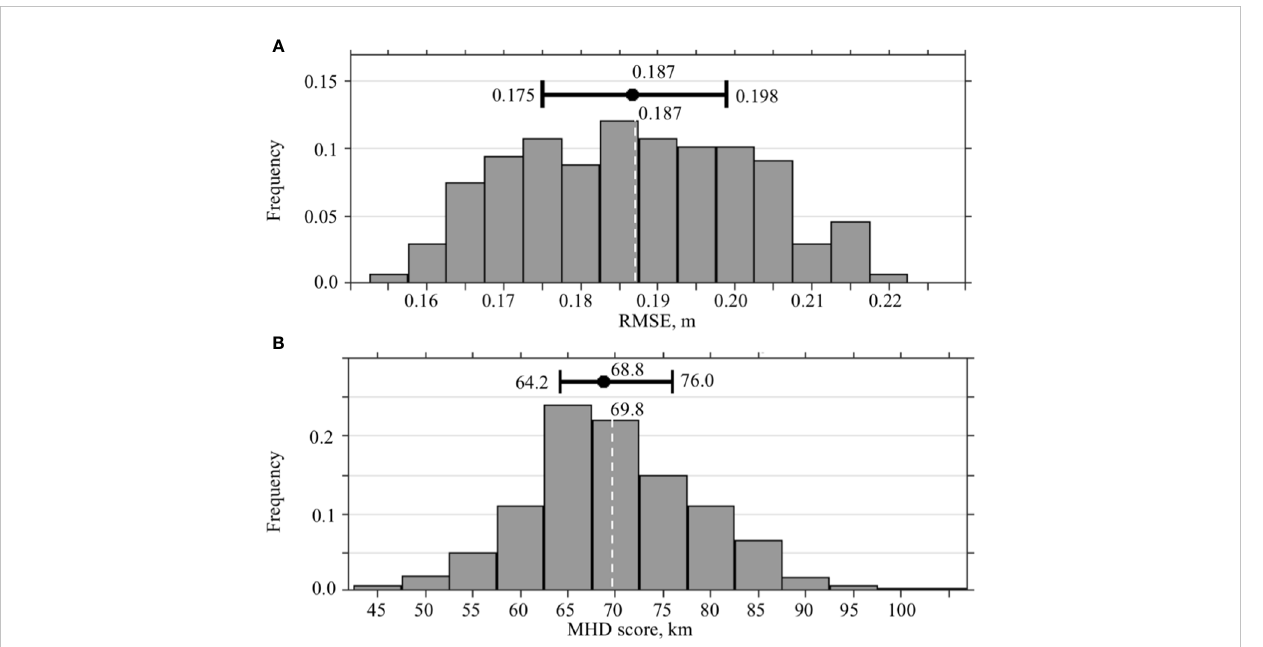
FIGURE 3 Statistics of the RMSE and MHD scores characterizing the saturation value. (A) Distribution of the RMSE between two randomly selected SSH fi elds form the NEMO NR. (B) Distribution of the MHD scores calculated for the LC/LCE fronts derived from randomly selected SSH fi elds from the NEMO NR. At the upper part of the diagrams, the median and IQR with the values are shown. The dashed white line is the expected value with the value listed at the